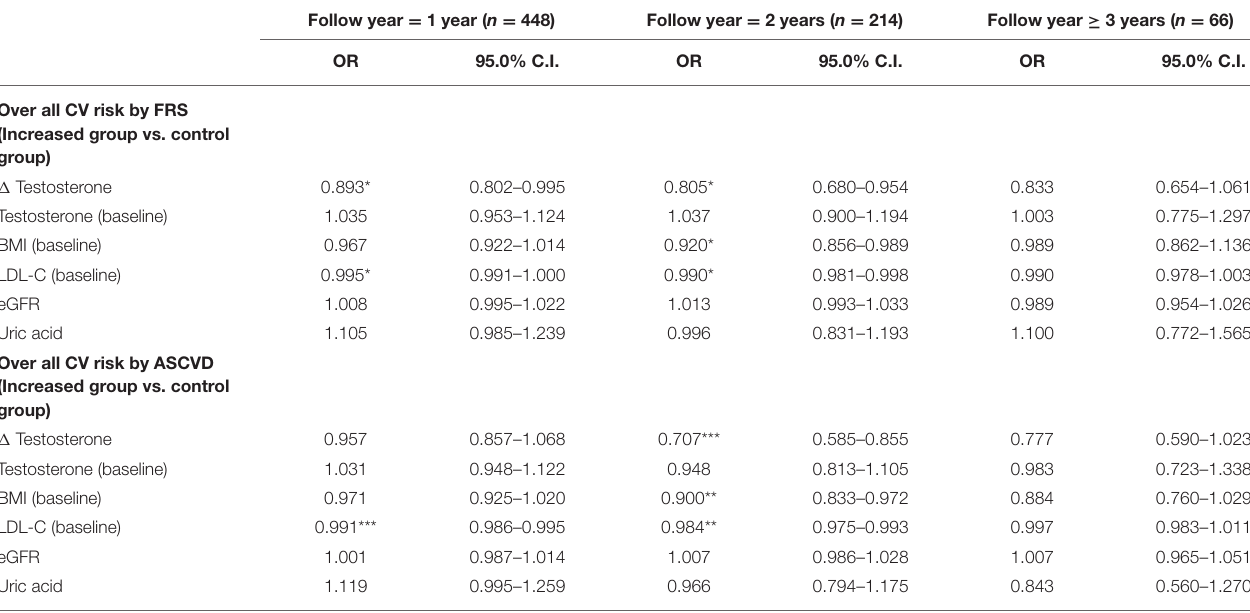
TABLE 3 | Logistic regression analysis of correlations based on time between medical checkups in participants aged 30–49